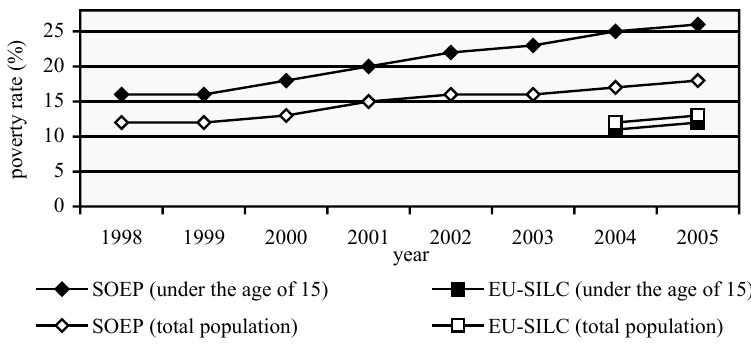
Figure 1: Poverty rate in different data-bases (60% poverty line; median): total population and children under the age of 15